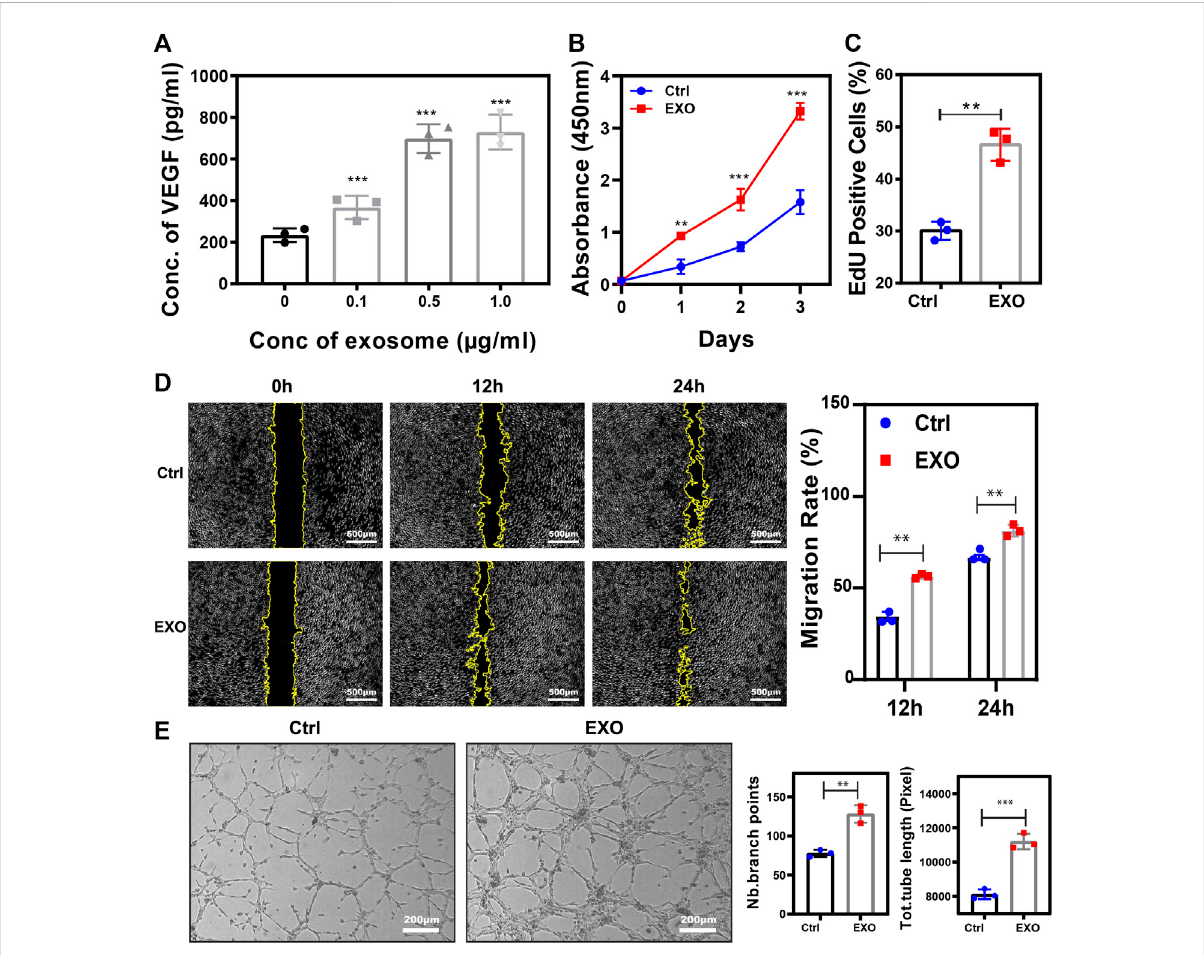
FIGURE 2 M2-EXO promotes Angiogenesis. (A) ELISA assay used to test VEGF concentration in gradient exosomes treated HUVEC culture medium. The VEGFconcentrationincreasedwithM2-EXOconcentrationfrom0 μ g/mlto1.0 μ g/mlandgottheoptimalconcentrationinthe0.5 μ g/mlgroup. (B) CCK-8 assaywas usedto estimate HUVEC viability. (C) Flow cytometry was usedto evaluate thepercentageofEdU-positivecells. Withahigher EdU positive cell count (46.6 ± 9.2%) than the control group (30.0 ± 5.7%), M2-EXO can increase DNA synthesis, indicating a proliferation improvement. (D) Wound healing assay used to test migration ability. Scratch distance and width closure was collected at 0 h, 12 h, and 24 h. The wound area collected at 0 h was quali fi ed and standardized as 100%. After 12 h, the control cells migrated and covered 29.3 ± 3.7% of the wound area, while the exosome incubation cells covered 56.4 ± 3.6% of the wound area. 24 h later, exosomes co-incubated cells migrated 94.5 ± 8.1% of the wound area, signi fi cantly higher than the migration area of the control cells. (E) Tube formation assay was used to demonstrate the in fl uence of M2-EXO on angiogenesis. ImageJ analyzed the number of branch points and the total tube length. M2-EXO incubated HUVECs had 9992.3 ± 745.8 sizes of entire tube and 76± 13.1 branch points, whichproved the angiogenesisimprovement ability of M2exosomes. Exosomes derived from M2 was presented as EXO in fi gures. Data was expressed as mean ± 3 σ ( n = 3); * = signi fi cant, * p < 0.05; ** p < 0.01,*** p < 0.005; **** p < 0.001, Student t